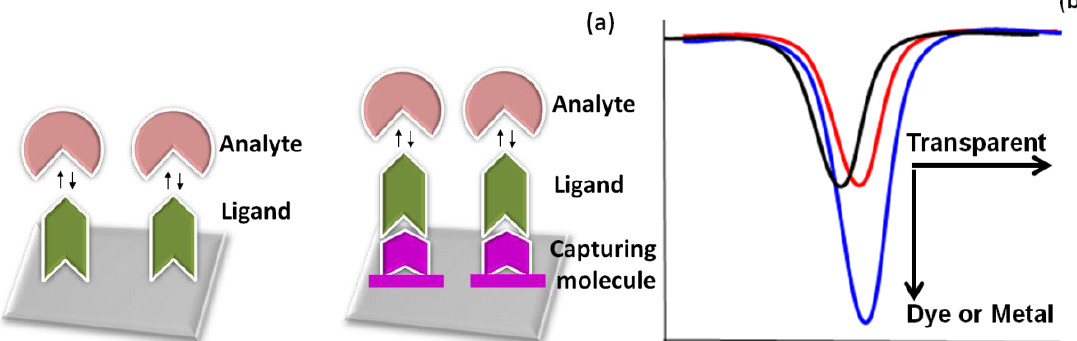
Figure 4. ( a ) Strategies for analyte and ligand interactions. Both direct and indirect immobilizations of the ligand on the chip are shown. The indirect immobilization requires appropriate chemical compounds as a linker; ( b ) Typical spectral changes for a waveguide-mode sensor. Horizontal (for transparent molecules) and vertical (for dyed or colored materials) changes are